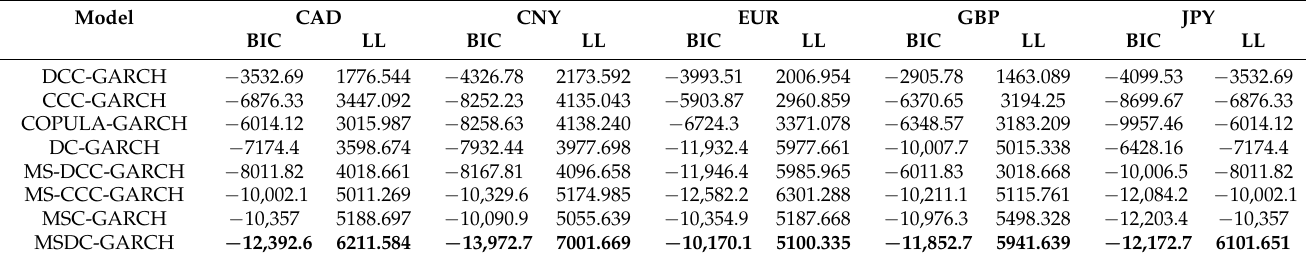
Table 8. BIC and Log-likelihood (LL) values for different models fitted to the 30-min returns of five currencies. Model